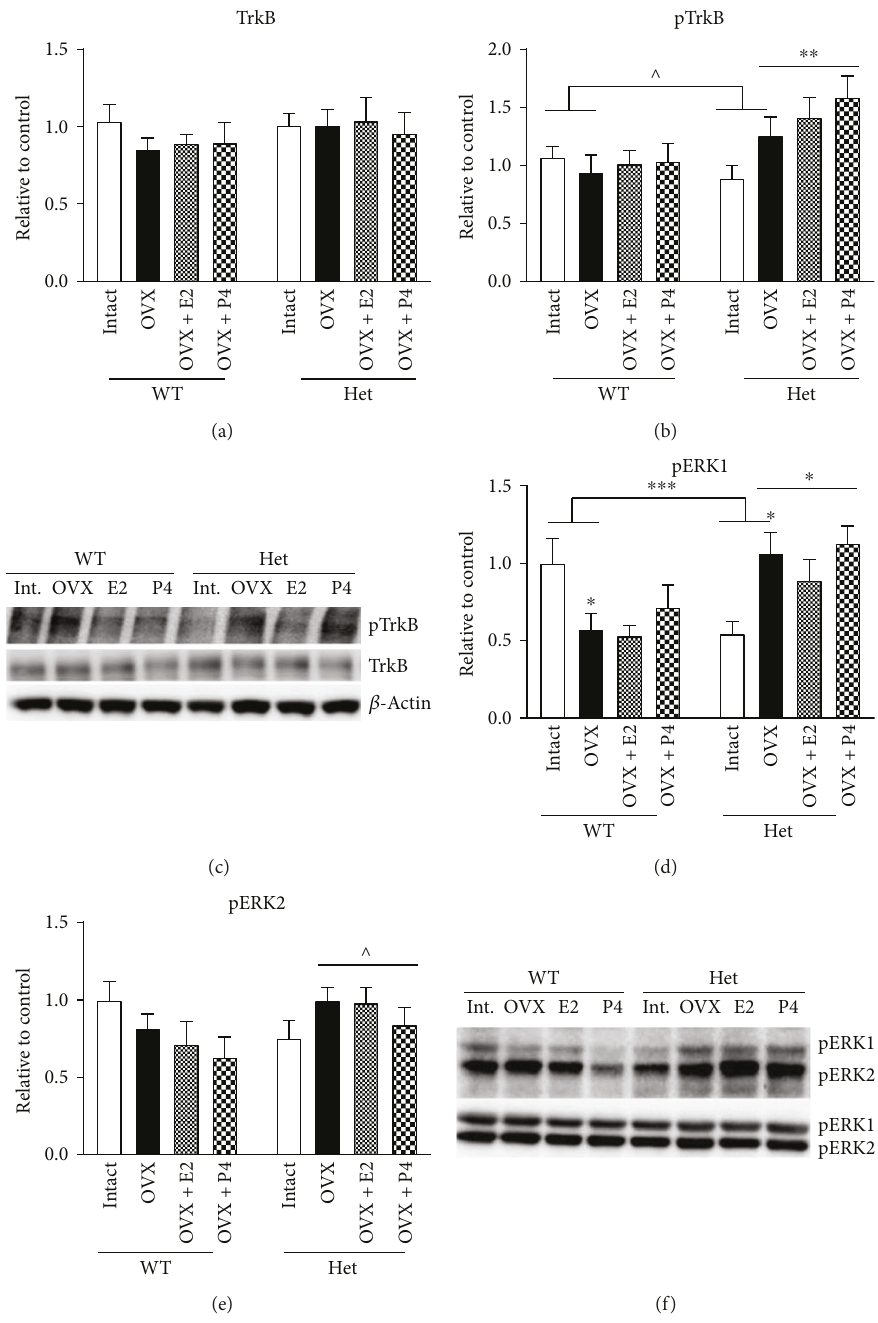
Figure 2: Protein expression of TrkB, pTrkB, and pERK1/2 in the dorsal (DHP) hippocampus of female sham ovariectomized+placebo (intact), ovariectomized+placebo (OVX), OVX +estradiol (E2), and OVX + progesterone- (P4-) treated mice. (a) Full-length TrkB in the DHP, (b) phosphorylated TrkB (Tyr515) in the DHP, (c) representative blots of TrkB and pTrkB, (d) phosphorylated ERK1 in the DHP, (e) phosphorylated ERK2 in the DHP, and (f) representative blots of pERK1 and 2 and total ERK1 and 2. N =5 – 7 per treatment group. ^ p < 0 1 , ∗ p < 0 05 , ∗∗ p < 0 001 , and ∗∗∗ p < 0 0001 . Error bars represent the standard error of the mean (SEM). Two-way ANOVA was performed. Bars with connecting horizontal lines show signi fi cant interactions (OVX × genotype), fl at bars represent signi fi cant main e ff ects of genotype, and ∗ above the OVX bar represents post hoc signi fi cant di ff erences between OVX and sham 3.8. PSD-95 in Female Hippocampus. A signi fi cant geno- type × OVX interaction ( F (1, 24) =5.200, p = 0 0318 ) was